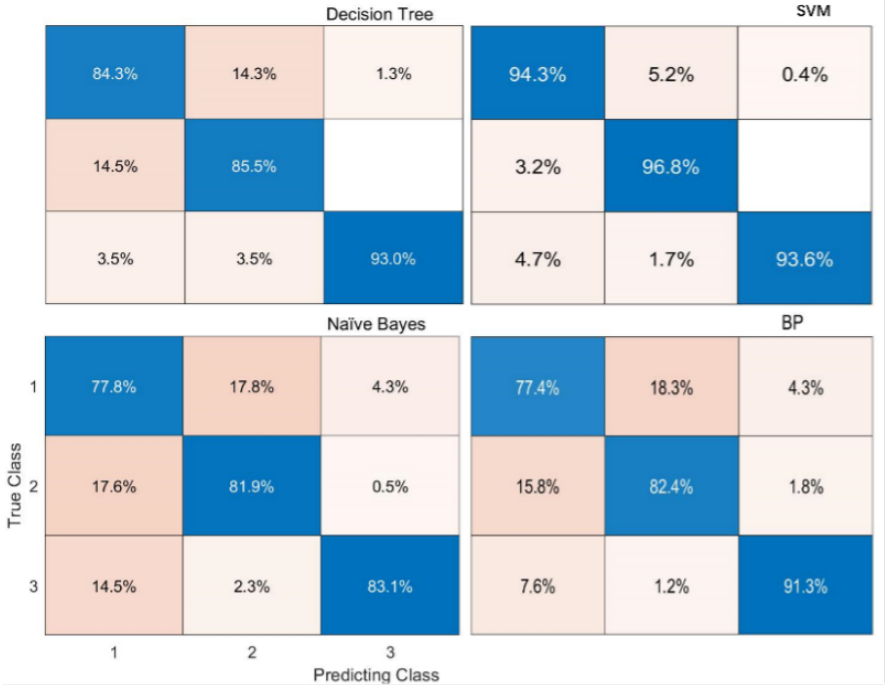
Figure 5. Confusion matrix of model